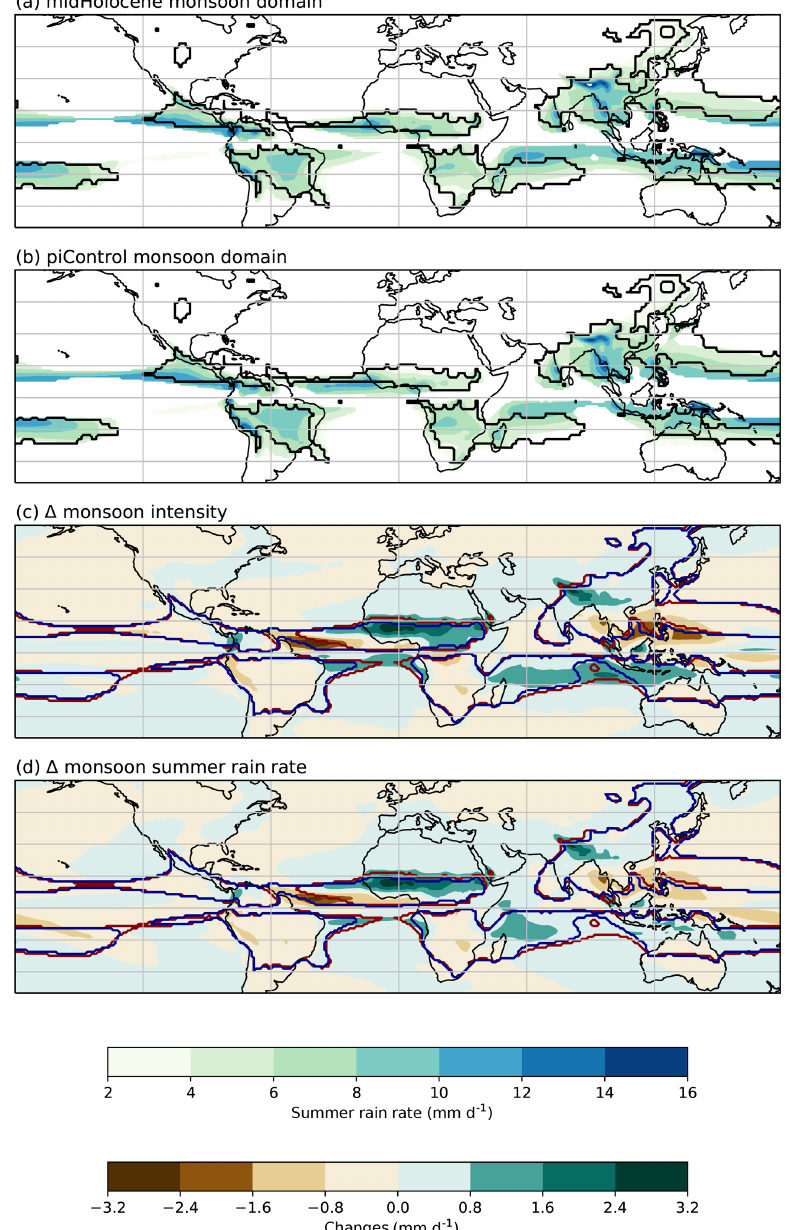
Figure 5. PMIP4-CMIP6 ensemble mean global monsoon domain (mmd − 1 ). The monsoon domain for each simulation is identified by applying the definitions of Wang et al. (2011) and in Sect. 2.2 to the PMIP4-CMIP6 ensemble mean of both (a) the midHolocene and (b) the piControl simulations. The black contour in panels (a) and (b) shows the boundary of the domain derived from present-day observations (Adler et al., 2003). The simulated changes in the monsoon domain are determined by changes in both (c) the monsoon intensity – average rain rate difference between summer and winter – and (d) the summer rain rate. In panels (c) and (d) the red and blue contours show the boundary of midHolocene and piControl global monsoon domains